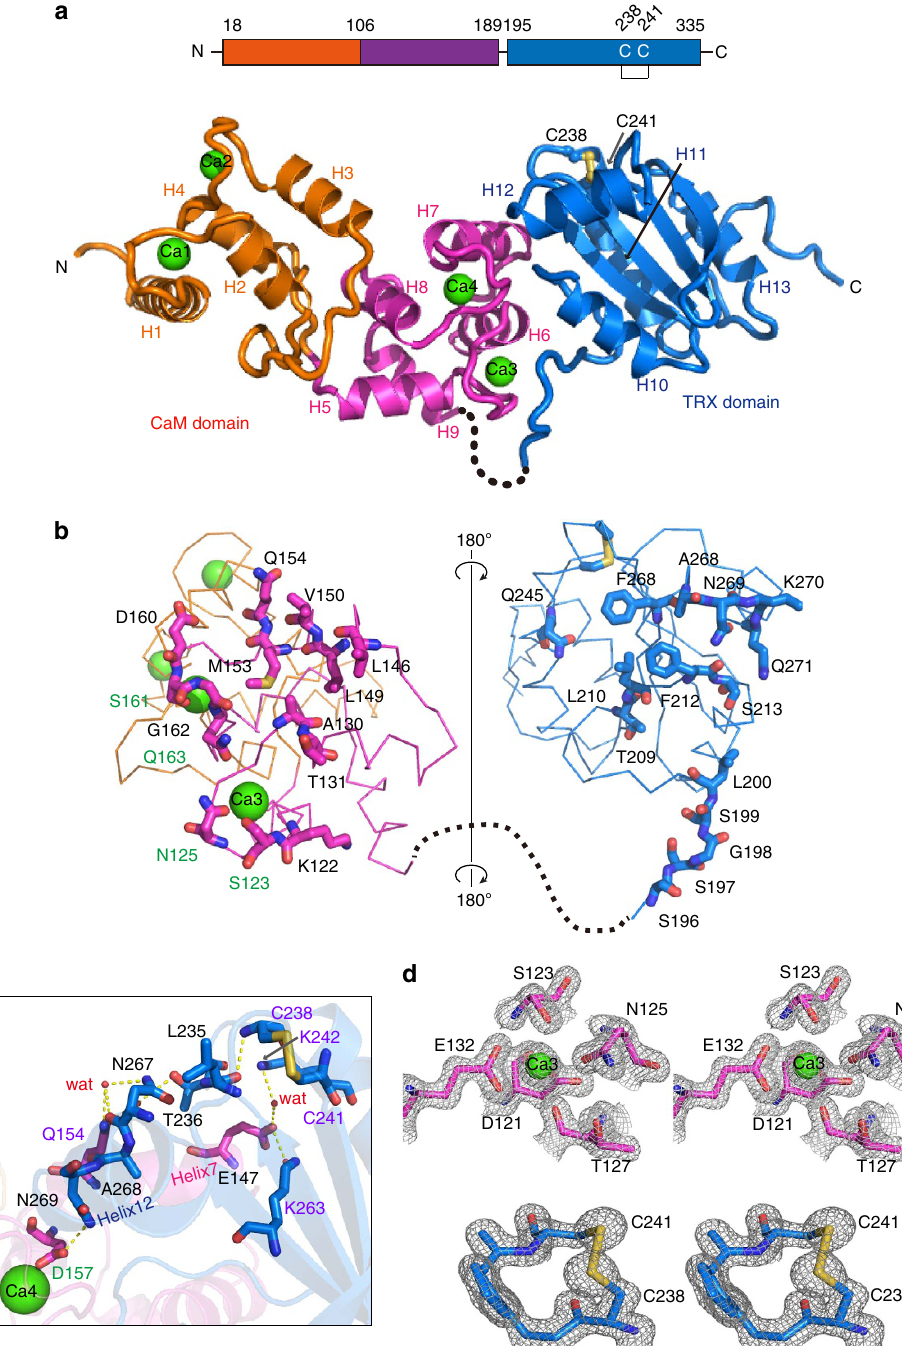
Figure 4 | X-ray structure of calredoxin. ( a ) Overall structure of CRX. Sequence diagram of CRX is shown at the top. The N- and C-subdomains of the CaM domain are displayed in orange and magenta, respectively. Bound Ca 2 þ ions are represented as green spheres. The TRX domain is highlighted in marine-blue with the disulfide bridge shown as yellow ball-and-stick model. ( b ) Open-book representation of interactions between the CaM and the TRX domains. Residues involved in direct inter-domain interactions except for water-mediated hydrogen bonds are shown. ( c ) Inter-domain networks between the Ca4 calcium ion in the CaM domain and the disulfide bridge in the TRX domain. Purple labels indicate the residues of structure based mutagenesis. ( d ) The stereo image of 2|F o |-|F c | electron density maps (2 s level) showing amino acid residues around Ca3 (upper) and the disulfide bridge between Cys238 and Cys241